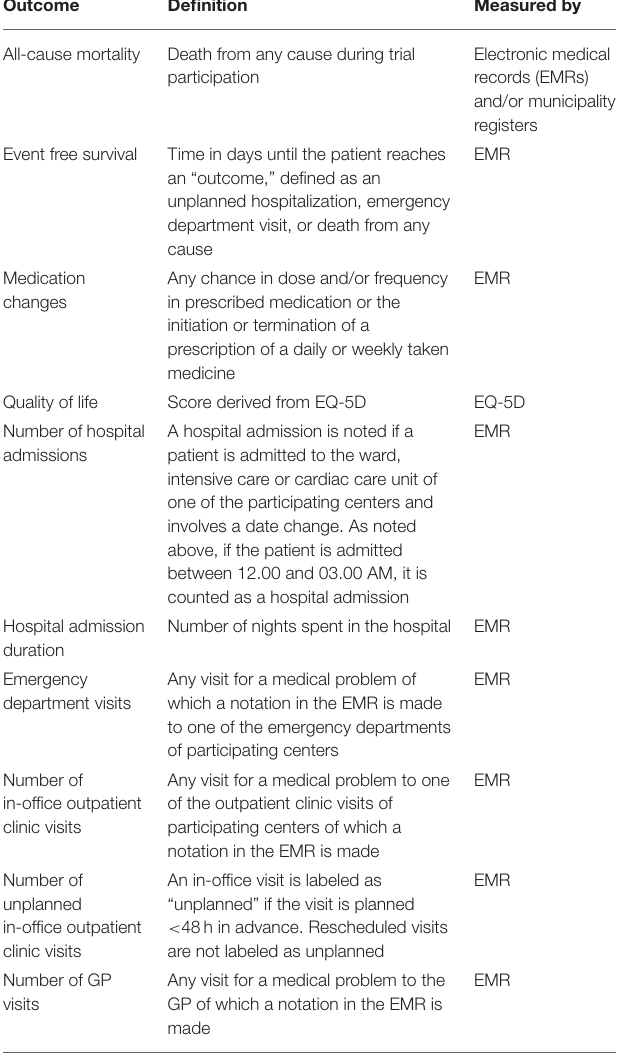
TABLE 3 | Secondary outcomes and their definitions.